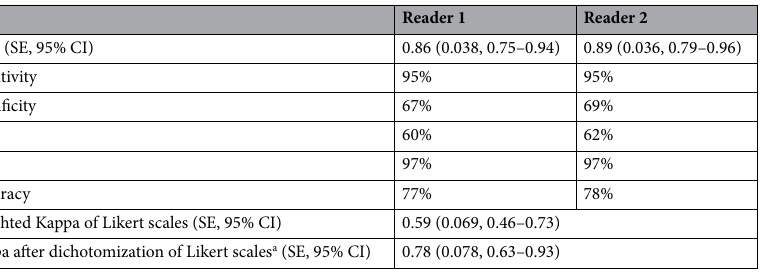
Reader 1 Reader 2 AUC (SE, 95% CI) 0.86 (0.038, 0.75–0.94) 0.89 (0.036, 0.79–0.96)